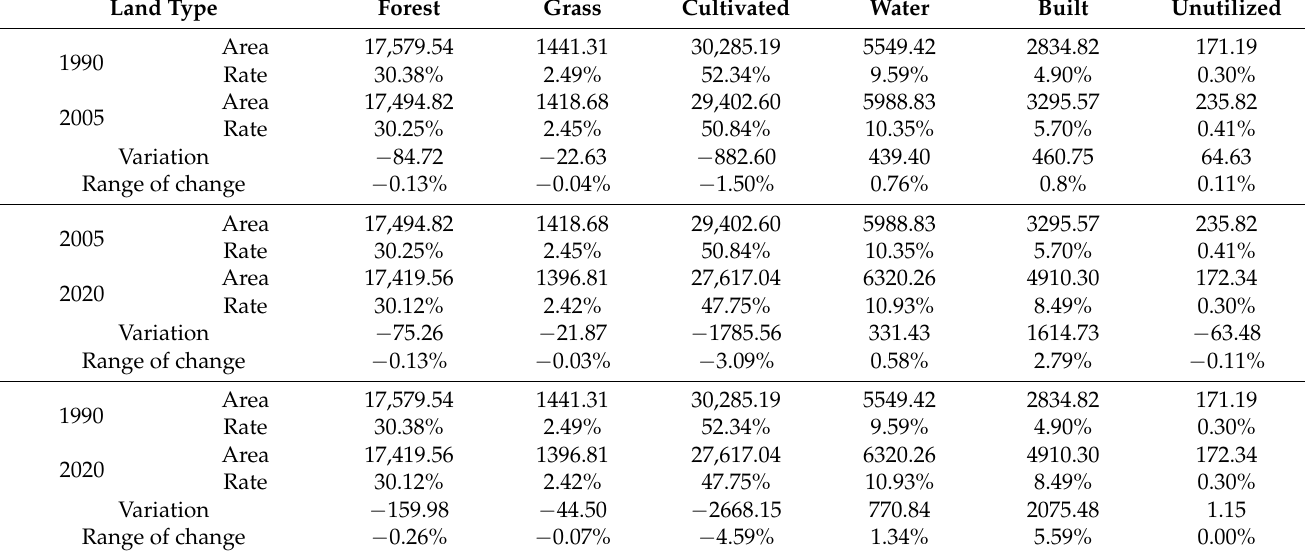
Table 2. Change of land use types in Wuhan metropolitan area from 1980 to 2020. Land